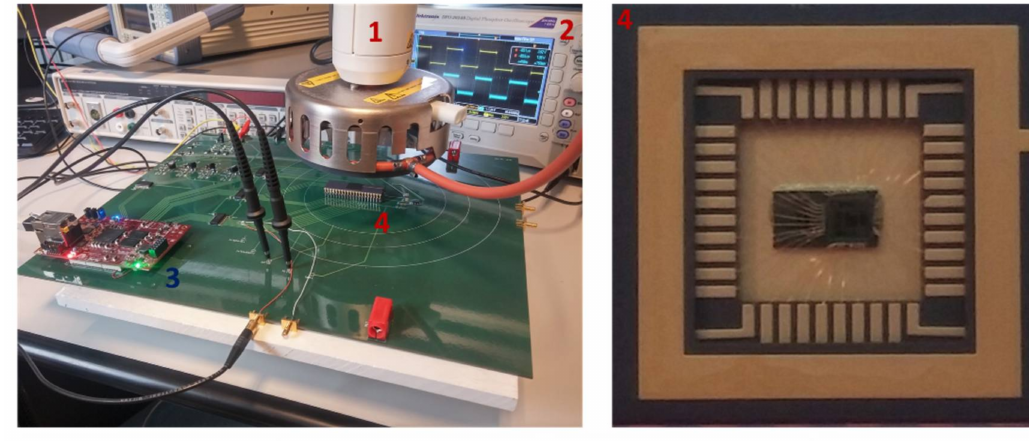
Figure 17. Characterization of the fabricated